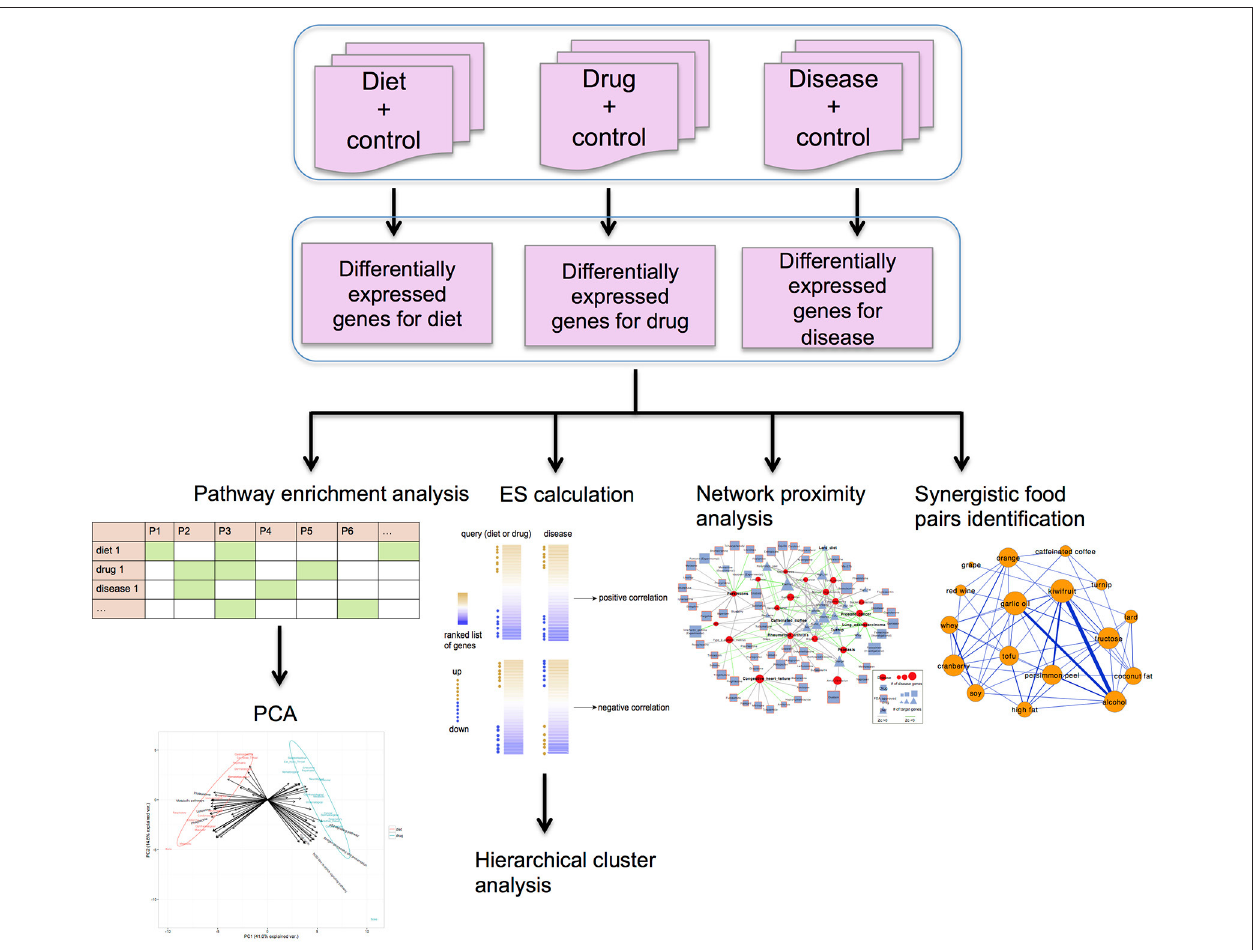
FIGURE 1 | The framework of our methodology applied in this study. The differentially expressed (DE) genes of diets, drugs and diseases were detected using the R package Rankprod, by comparison with respective control groups. The R package Gostats was applied for KEGG pathway enrichment analysis. The identified significant pathways for diets, drugs and diseases were used to construct the score matrix for the PCA. Diet-disease and drug-disease associations were calculated using the enrichment score (ES) method in DvD package. Hierarchical analysis was performed to show disease similarity based on the ES scores. Using a python script developed by Guney et al. (2016), we measured the proximity values between DE genes of diets or drugs and diseases within a human protein-protein interaction (PPI) network. Synergistic food pairs were identified using the approaches from Bansal et al.